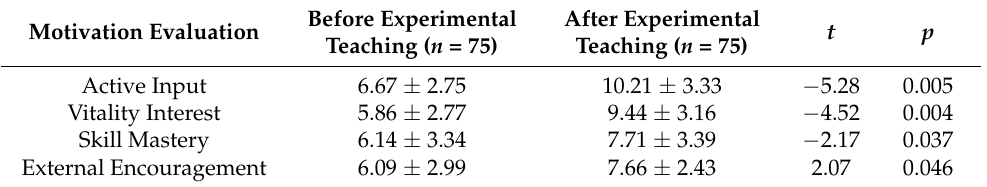
Table 7. Comparison of Motivation Evaluation Variables of EG before and after Experimental Teaching.